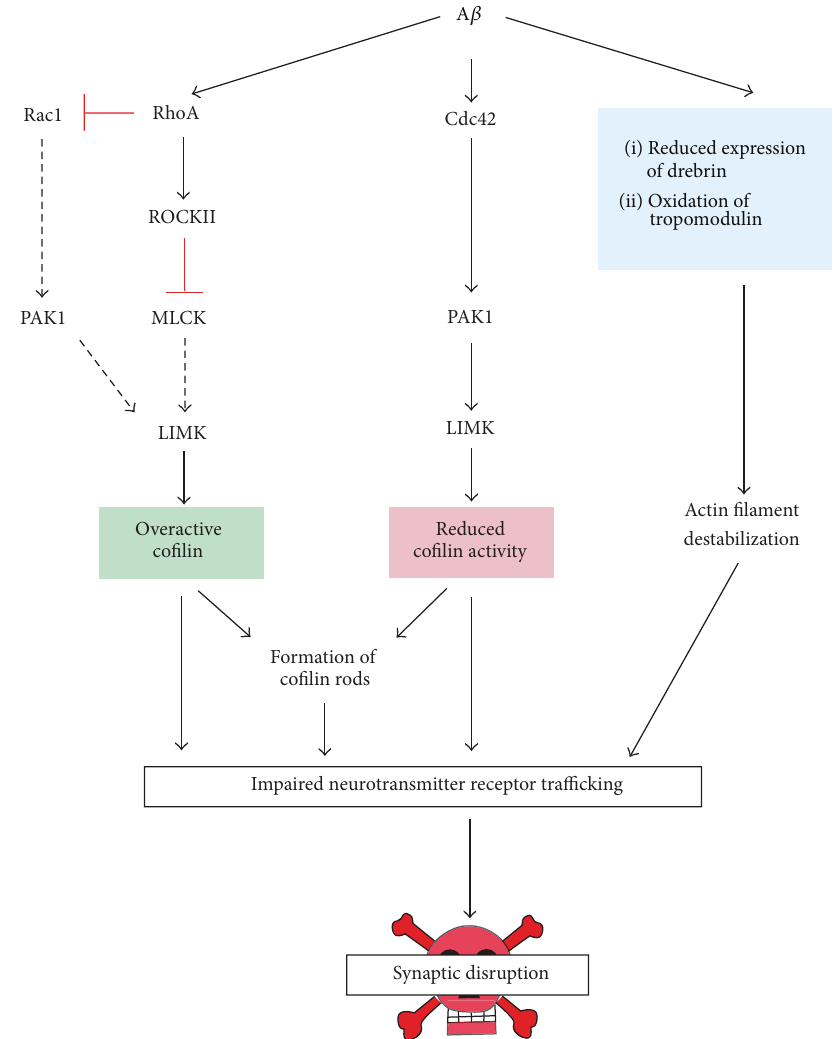
Figure2:Amyloid- 𝛽 disruptstheactincytoskeletonandreceptortraffickingthroughmultiplepathways.Therearemanyconflictingpathways through which A 𝛽 is proposed to alter the actin cytoskeleton. These may involve both up- and downregulation of cofilin activity. Activation of RhoA by A 𝛽 [204] antagonistically inhibits Rac1 [206], both leading to increased cofilin activity. In contrast, A 𝛽 can cause decrease in cofilin activity via activation of Cdc42 [211]. Both active and inactive cofilin are thought to be required for the formation of cofilin rods, which lead to impairment of intracellular transport [215]. Alternatively or in addition to this, altered expression and/or processing of actin filament stabilizing proteins [217, 218] may impact the trafficking of neurotransmitter